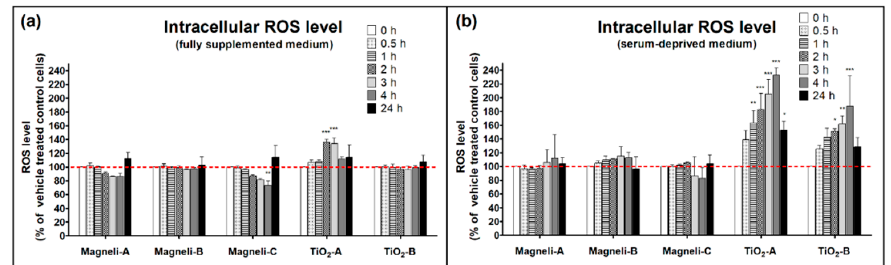
Figure 5. Intracellular reactive oxygen species (ROS) levels in A549 cells after 0, 0.5, 1, 2, 3, 4, and 24 h exposure to nanoparticles in ( a ) fully supplemented cell medium and in ( b ) serum-deprived cell medium. For the evaluation of intracellular ROS levels, the ROS-sensitive indicator 2 ′ ,7 ′ - dichlorofluorescein diacetate (DCFH-DA) was used. At least 20,000 events were measured for every sample, and for each treatment condition, two repetitions were done. Results are presented as an average 2 ′ ,7 ′ -dichlorofluorescein (DCF) fluorescence (+SD) according to vehicle treated control cells (dashed line). An asterisk presents a significant difference with respect to the control cells (* equals p < 0.05; ** equals p < 0.01; *** equals p < 0.001; ANOVA with Bonferroni’s post test).